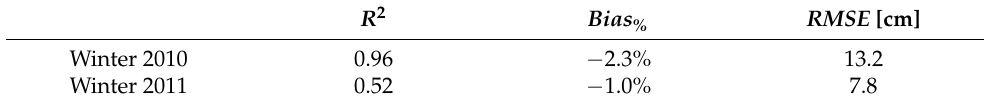
Figure 2. Snowpack (HS) evolution in time, with total precipitation (reconstructed) and temperature for the station of Courmayeur Mont de la Saxe. ( a ) 2010. ( b ) 2011. Table 1. Calibration and validation statistics ( Bias % , R 2 , RMSE ) for the snowpack during the considered season of winter 2010 and 2011 for the station of Courmayeur Mont de la Saxe. R 2 Bias % RMSE